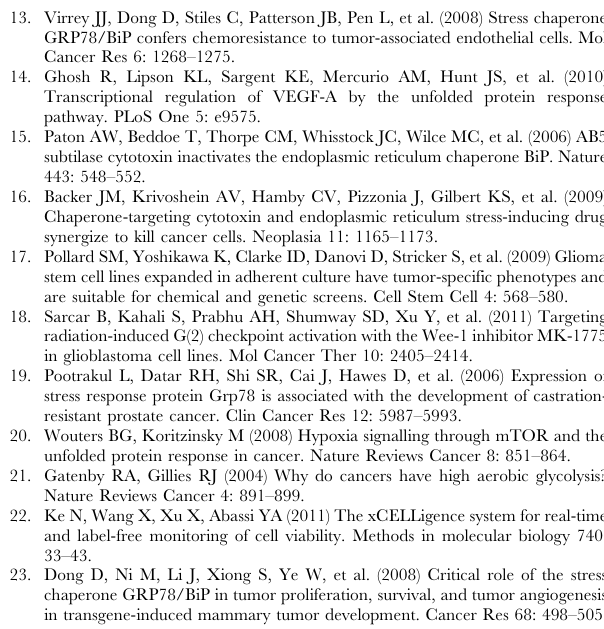
Figure S1 Samples Histology and densitometry. Histol- ogy of samples used in the glioma tissue microarray (A). Densitometry analysis of Western blots (B). Figure S2 EGFR and GRP78 expression in tumor cells. Depicted cell lines were lysed and total cellular protein isolated to evaluate for (A) EGFR and (B) GRP78 expression by immunoblot. Each figure is a representative of three independent experiments.